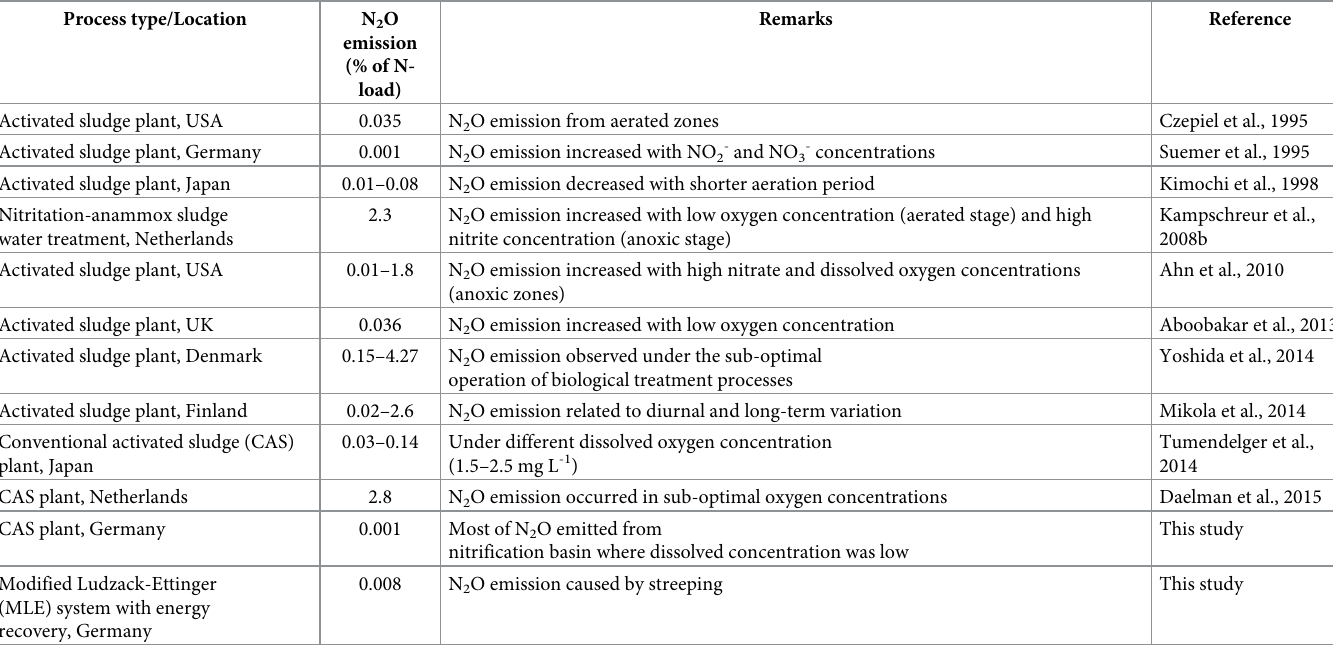
Table 3. Nitrous oxide (N 2 O) emission factors reported for several full-scale wastewater treatment